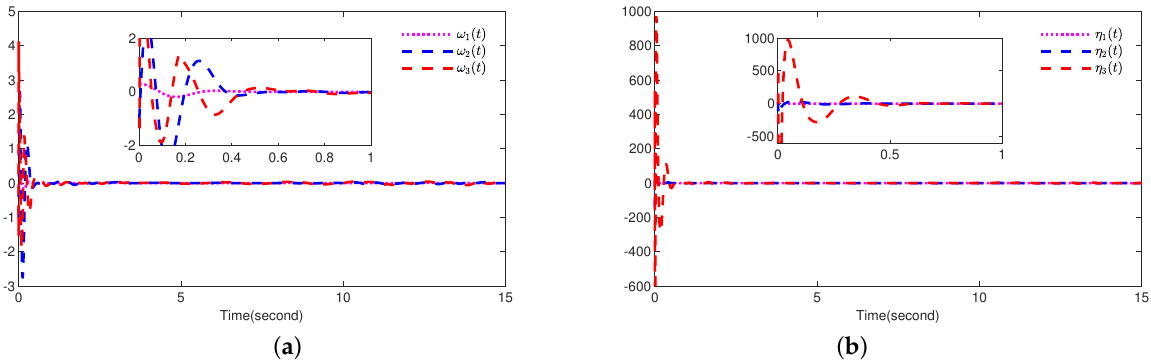
Figure 3. Time response of filters: ( a ) virtual input α 1 and filter output e c ; ( c ) actual input u and filter output e c filter output e c 2